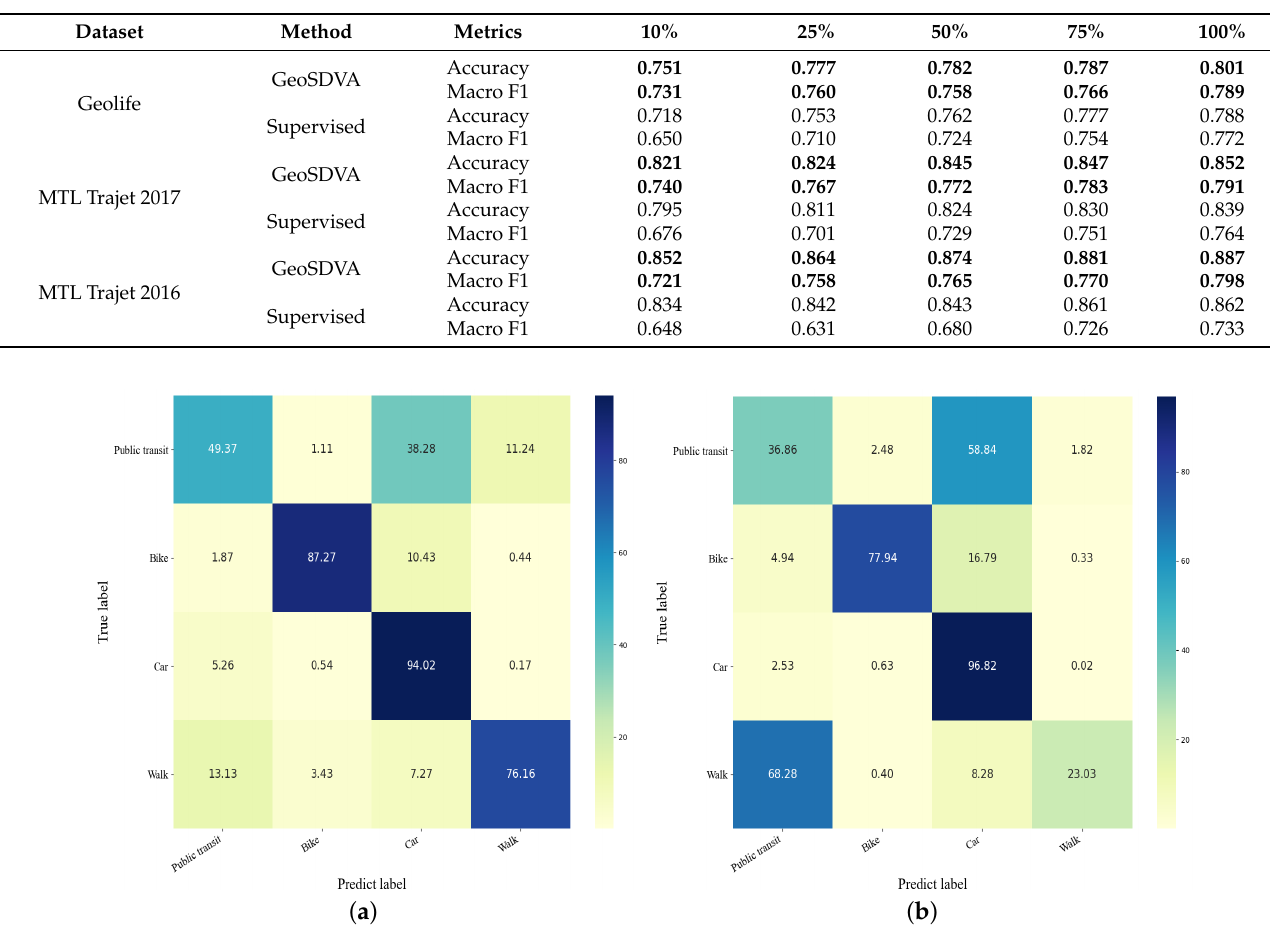
Table 8. The performance of the supervised and semi-supervised models